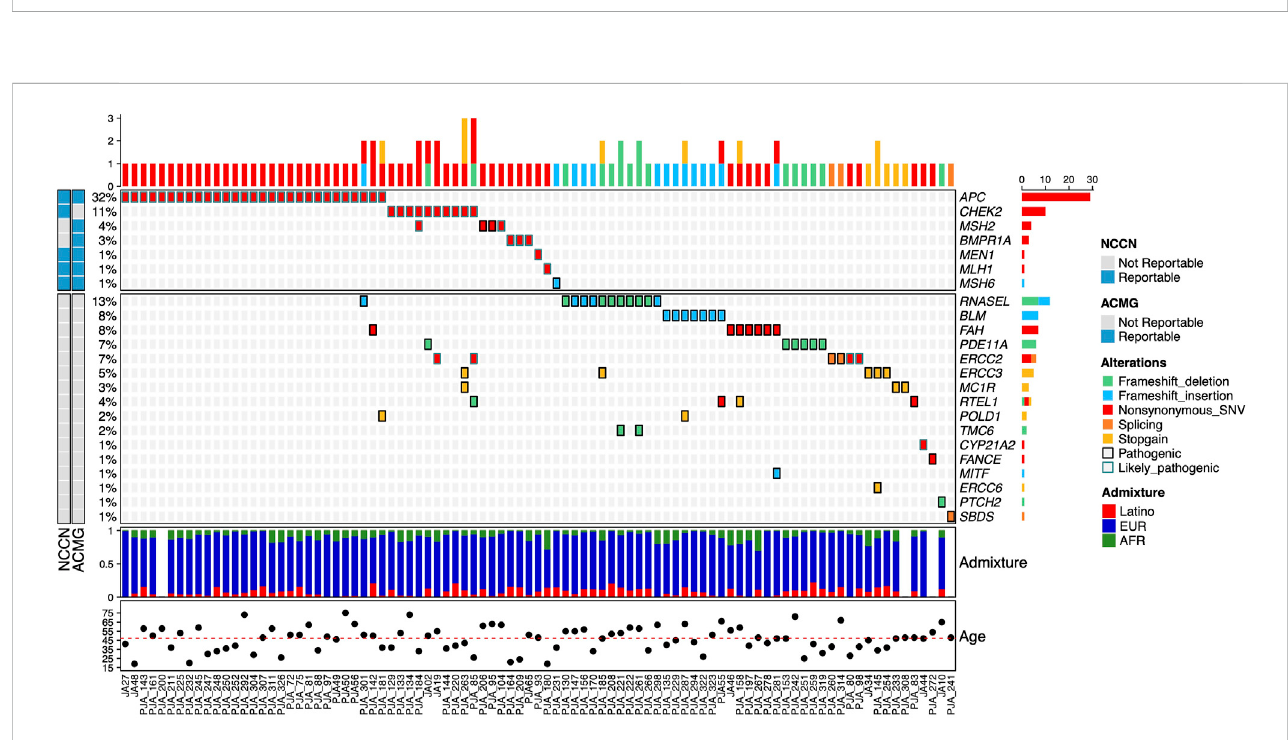
FIGURE 2 Allelic distributionof pathogenic variantsin high-risk genes for HBOCand genes with unknown risk level.The relativefrequencies,typeofmutation,and NCCN and ACMG reportable genes are shown in the upper panel. The center panel illustrates pathogenic variants detected in genes with unknown or insuf fi ciently documented risk of HBOC. The lower panel represents the three-component admixture distribution of the participants. The mutation type (alterations) and admixture component are color-coded. The relative frequency and total count for gene alterations are shown in the left and